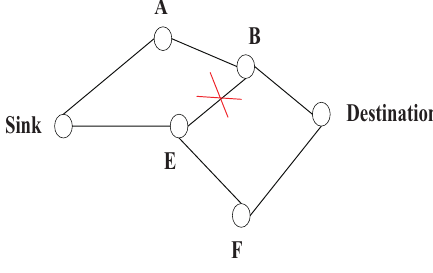
Figure 9. Construct disjoint